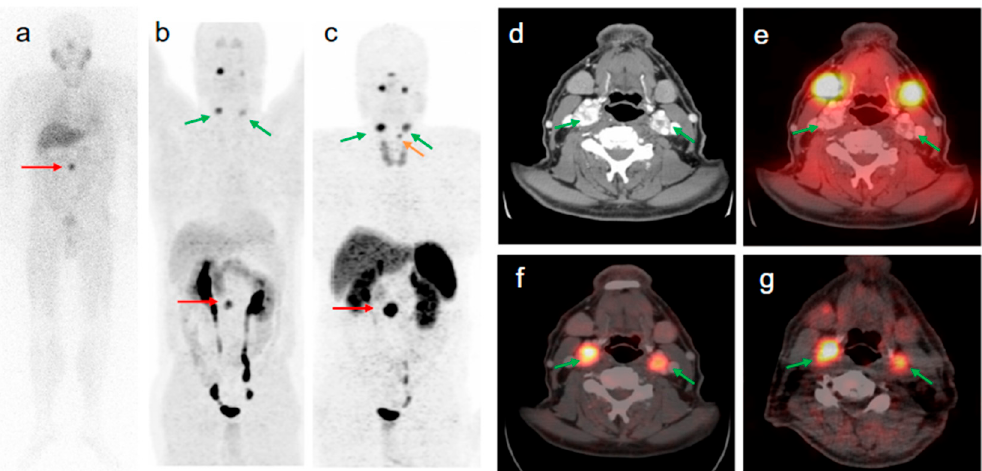
Figure 5. 58-year old male patient with malignant extra-adrenal PGL. The intense focal [ 123 I]MIBG uptake of the abdomen seen on anterior planar image (( a ) red arrow) was confirmed by [ 68 Ga]Ga-DOTA-TOC- and [ 18 F]FDOPA PET / CT as being a soft tissue extra-adrenal PGL (( b , c ) red arrows). After retrospective software-based image fusion of SPECT images with diagnostic CT images ( d ), symmetrical physiological [ 123 I]MIBG uptake was observed in the parotid and submandibular glands ( a , e ). All verified head and neck lesions with focal [ 68 Ga]Ga-DOTA-TOC (( c , f ) green arrows) and [ 18 F]FDOPA uptake (( b , g ) green arrows) were [ 123 I]MIBG negative ( a , e ). The small focus of [ 68 Ga]Ga-DOTA-TOC uptake superior to the left upper lobe of the thyroid gland (c orange arrow) is a PGL lesion of the larynx (confirmed by diagnostic CT) which was negative in [ 18 F]FDOPA PET ( b ). Compared to [ 123 I]MIBG imaging (including SPECT / CT), [ 68 Ga]Ga-DOTA-TOC PET / CT changed the tumor staging from non-malignant to metastatic disease. Reproduced from [43].